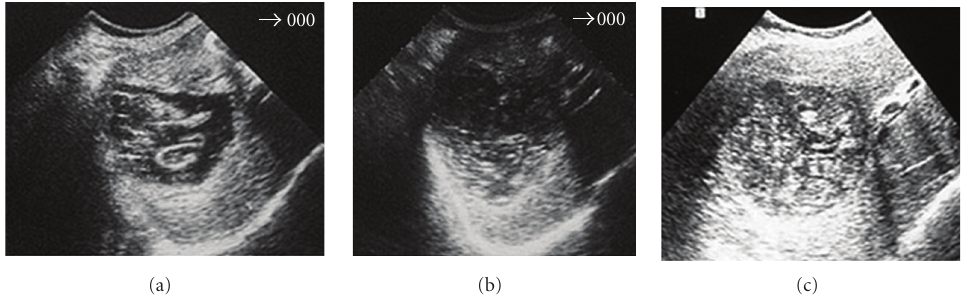
Figure 4: Hydatid cyst of the liver submitted to PAIR: (a) Immediately after PAIR; (b) 3 months later; (c) 1 year later.